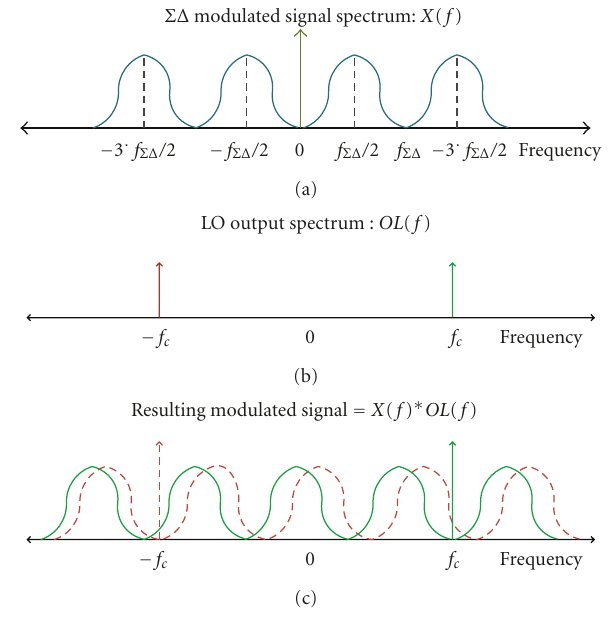
Figure 6: Modulation of the envelope ΣΔ coded signal.